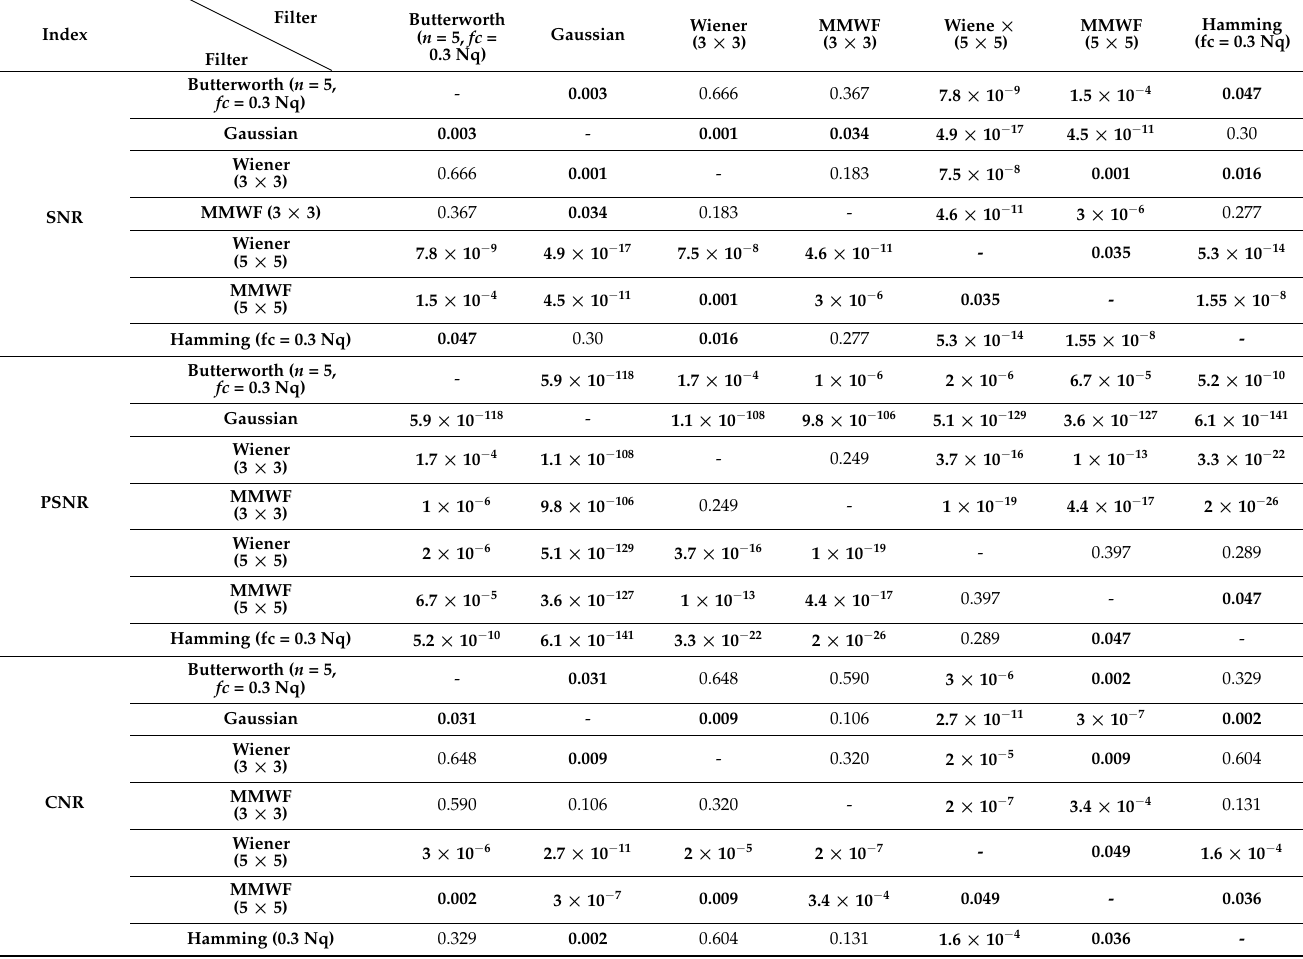
Table 4. p -values obtained using one way-ANOVA test to compare different filters for the studied myocardial perfusion SPECT images ( p -values in bold are less than